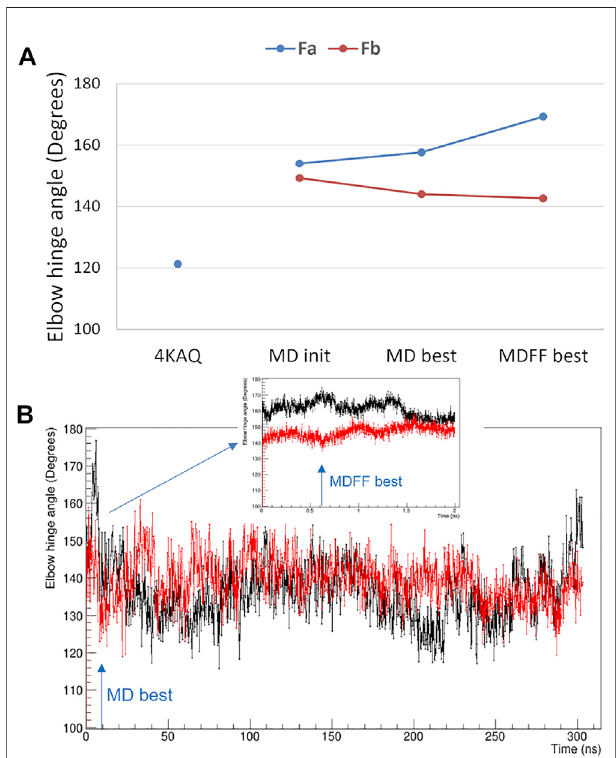
FIGURE 5 | Elbow angle, i.e., the angle between the variable and constant Fab domains. (A) comparison of values measured from the crystal structure with PDB code 4KAQ and from both Fab domains of the full-length model used for MD simulations: initial model (MD init), best- fi tting model in unrestrained MD (MDbest) and best- fi ttingmodel inMDFF(MDFFbest); (B) Fa (black line) and Fb (red line) elbow angle values as a function of the simulated time for the unrestrained MD and the MDFF simulation (inset). The simulation time corresponding to MD best and MDFF best is highlighted with arrows.